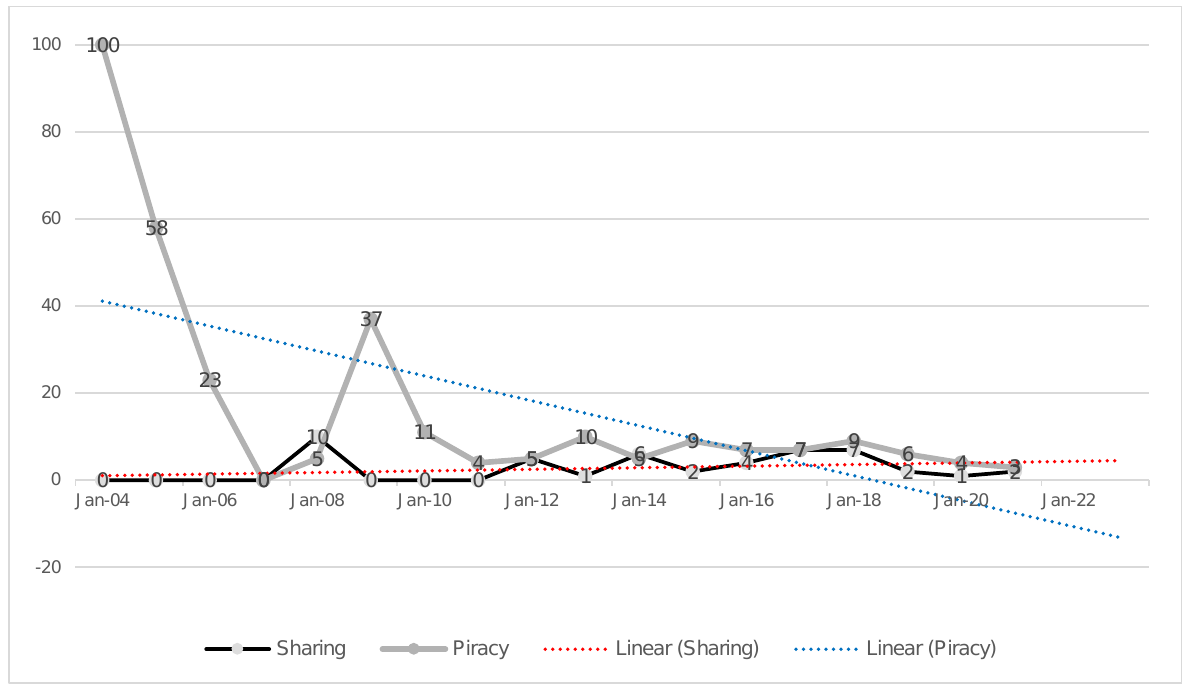
Figure 5: Search Interest Trendline for piracy (blue) vs sharing (red) metaphor clusters from 2004 to 2022 (forecast) Data source: Google Trends